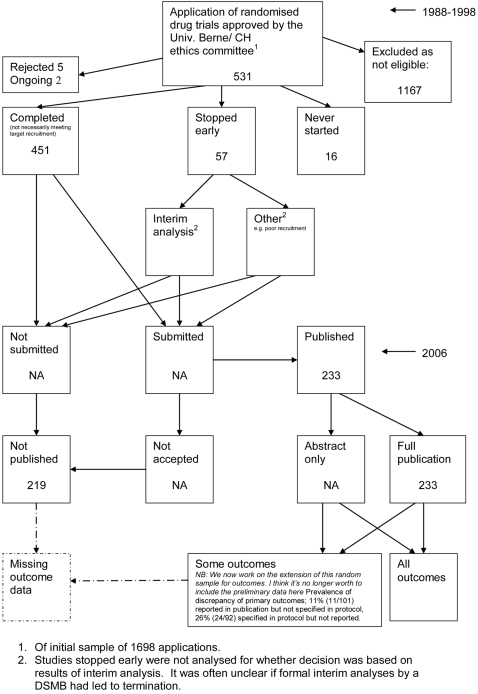
Status of approved protocols for von Elm 2008 study [18].